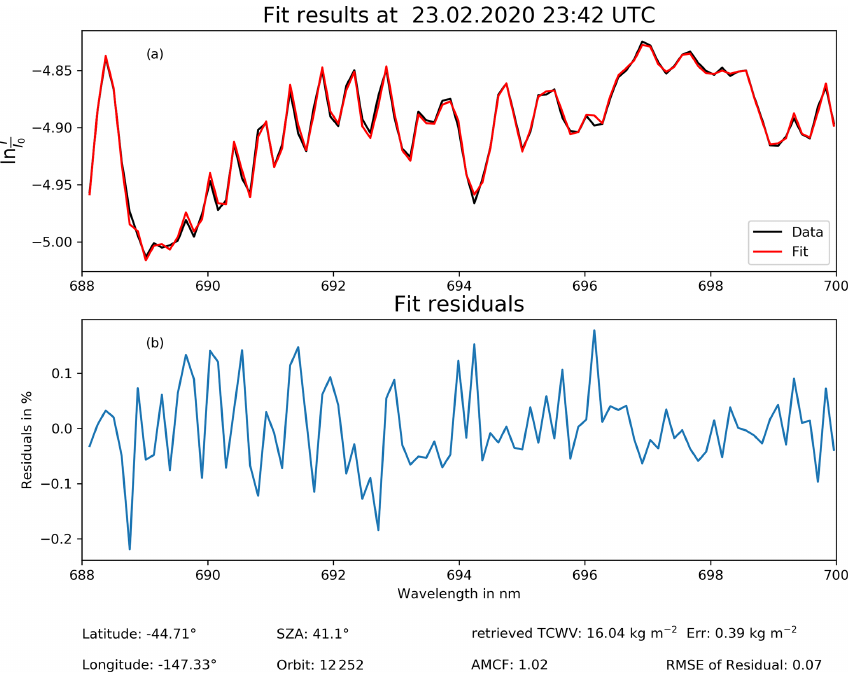
Figure 1. (a) Example measurement (black) from S5P and fit (red). (b) Relative fit residual (relative difference between measurement and fit) in